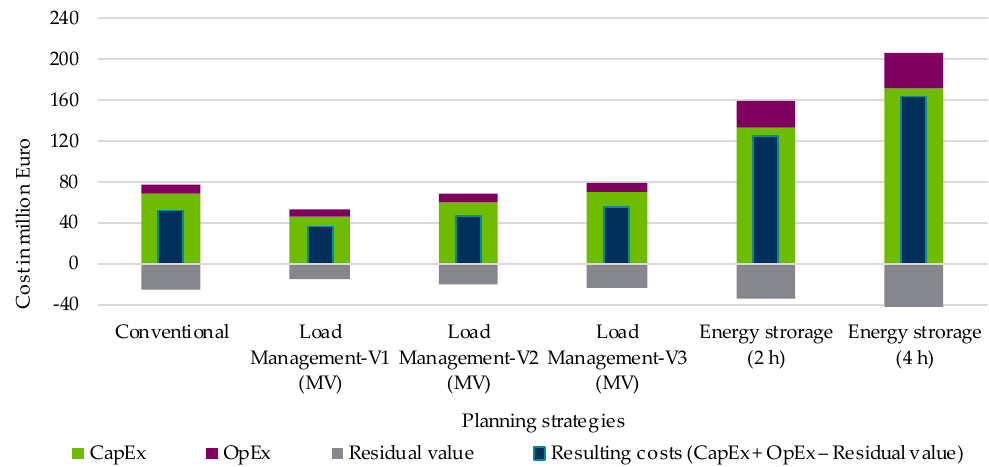
Figure 10. Consolidated costs in millions of Euros for all analyzed medium voltage grids for different planning strategies.